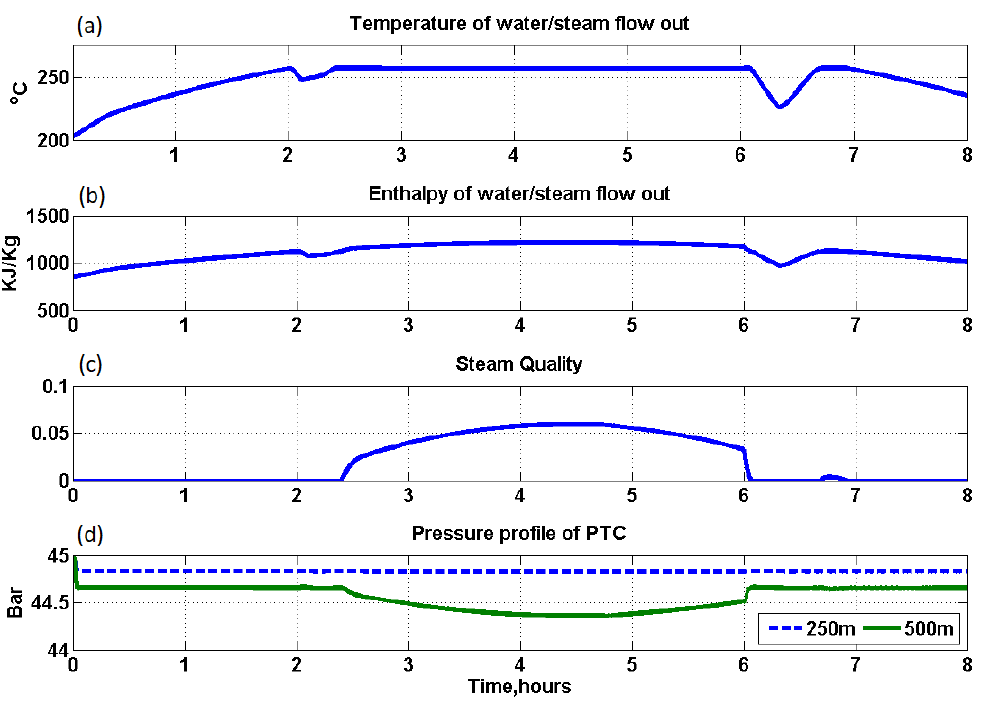
Figure A1. PTCWAT profile QOL ( stq ) : ( a ) temperature of water/steam at 500 m; ( b ) enthalpy of water/steam at 500 m; ( c ) steam quality at 500 m; ( d ) pressure variation at 250 m and 500